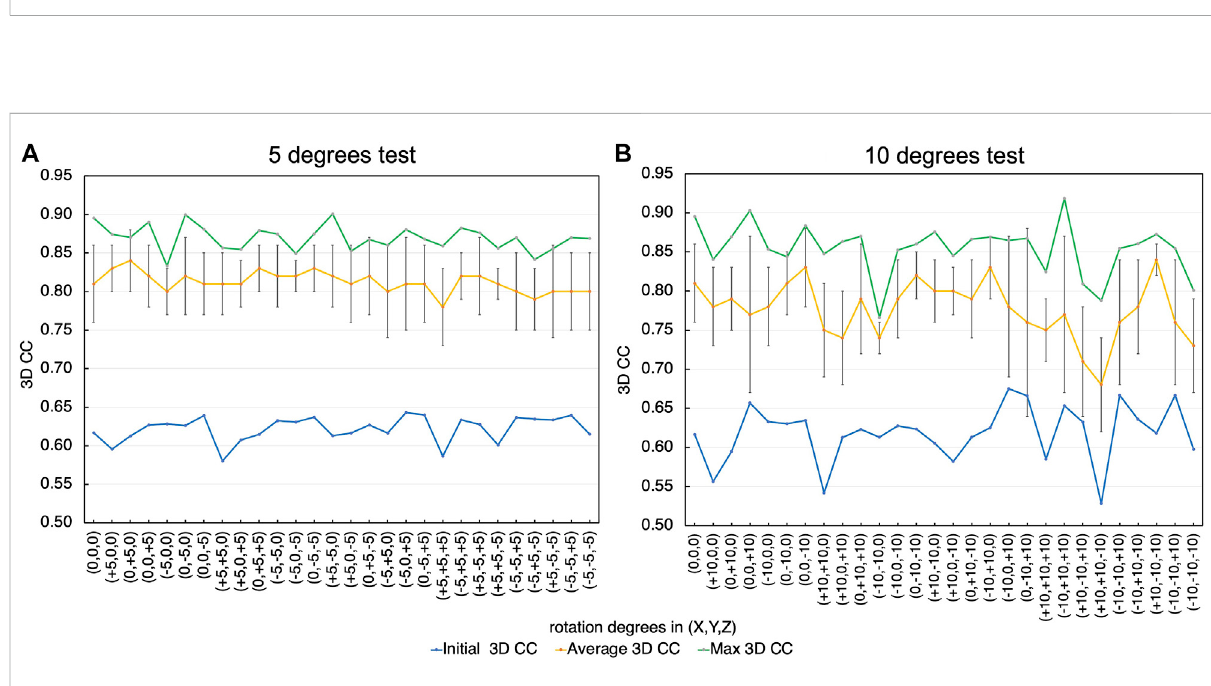
FIGURE 10 Diffraction patterns and GMM representations of initial and target conformations of EF2 test obtained for X = 60 ° and Y = 60 ° , one of the orientations that did not work well. (A) and (B) are simulated XFEL diffraction patterns from initial and target GMM models, respectively. 2D CC between (A) and (B) is0.30. (C) Theinitialmodelisinpink,thereferenceGMMrepresentationofthetargetmodelisbluemesh.Initial3DCCbetween the initial model and target is 0.62.